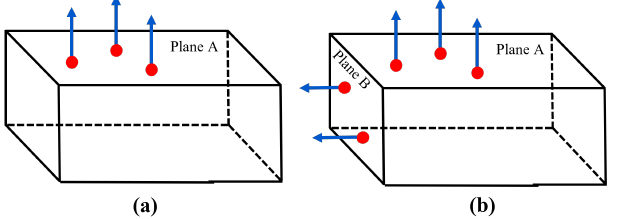
Figure 4. Distribution of MPs. ( a ) The MPs are distributed in the same plane ( b ) The MPs are dis- tributed in adjacent